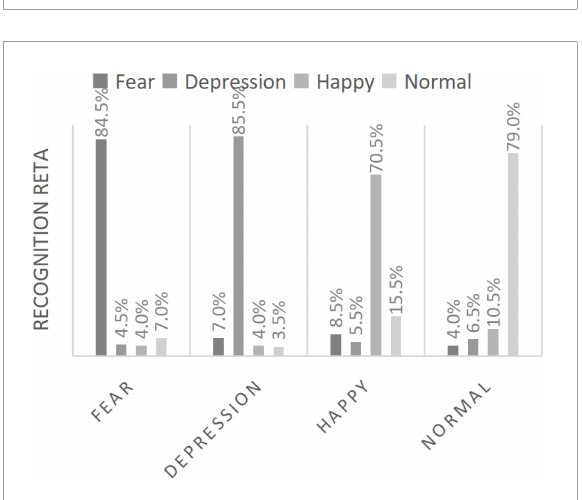
FIGURE3 Face facial emotion recognition rate.